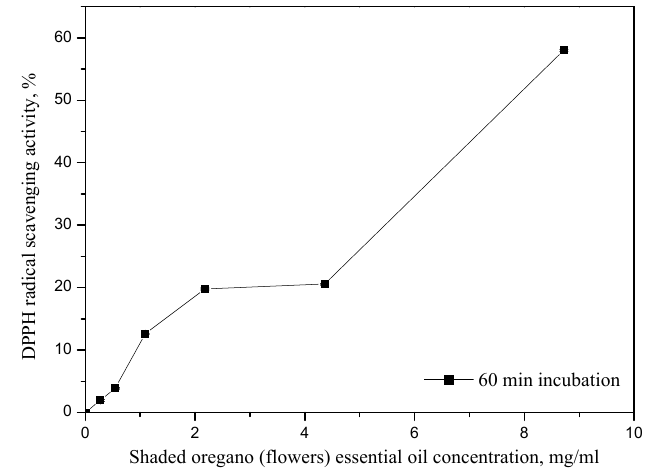
Figure 3. Antioxidant activity of shaded oregano (flowers) essential oil.